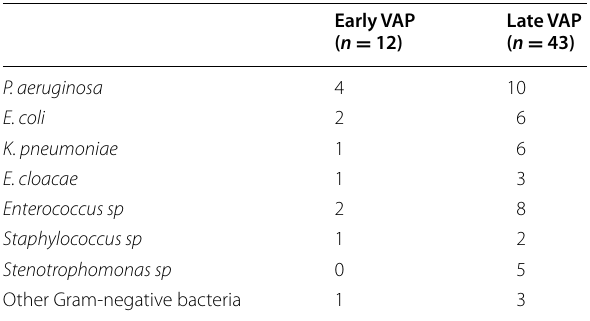
Table 1 Microbiological documentation depending on